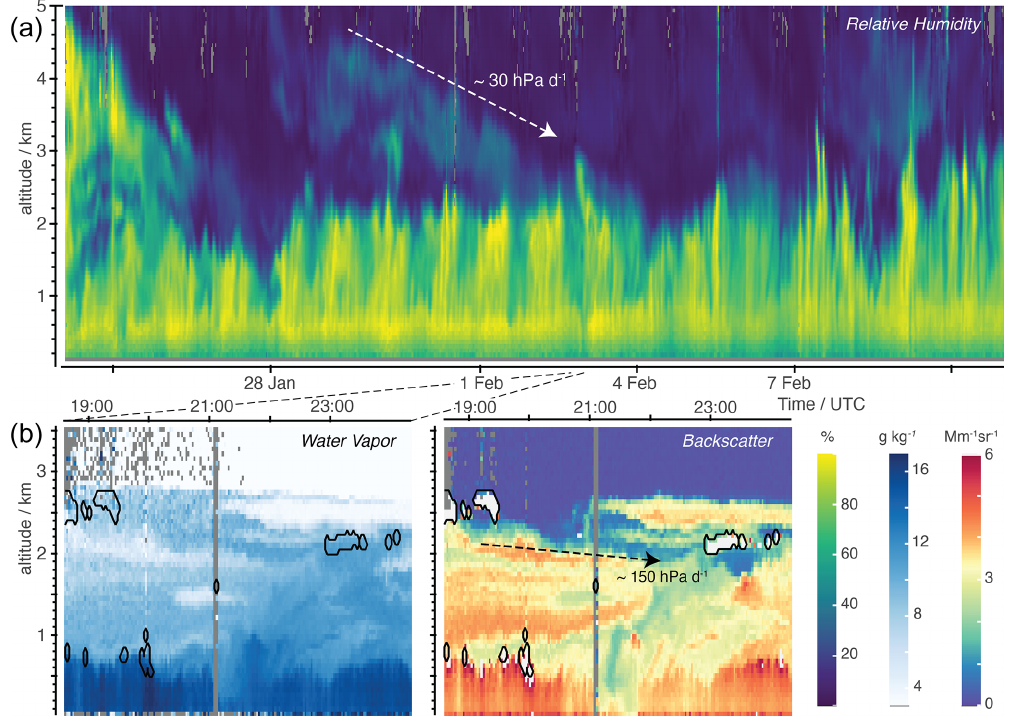
Figure 13. Lidar profiling of the lower atmosphere using the CORAL lidar at the Barbados Cloud Observatory. The upper panel (a) shows the relative humidity in the lower 5km over the entirety of the campaign. The lower panel (b) shows (from left to right) show the specific humidity over a 4h period marked by a large intrusion of cloud layer air on 2 February and the associated aerosol/cloud backscatter. Also shown is the Lagrangian evolution of humidity, or backscatter features, with dashed arrows following the descent with time of features (white arrow in the upper panel: following RH feature; black arrow in the lower panel: following backscatter feature) being indicative of the magnitude of vertical velocity variations on different temporal scales. Gray bars on lower plots (at 21h) are missing